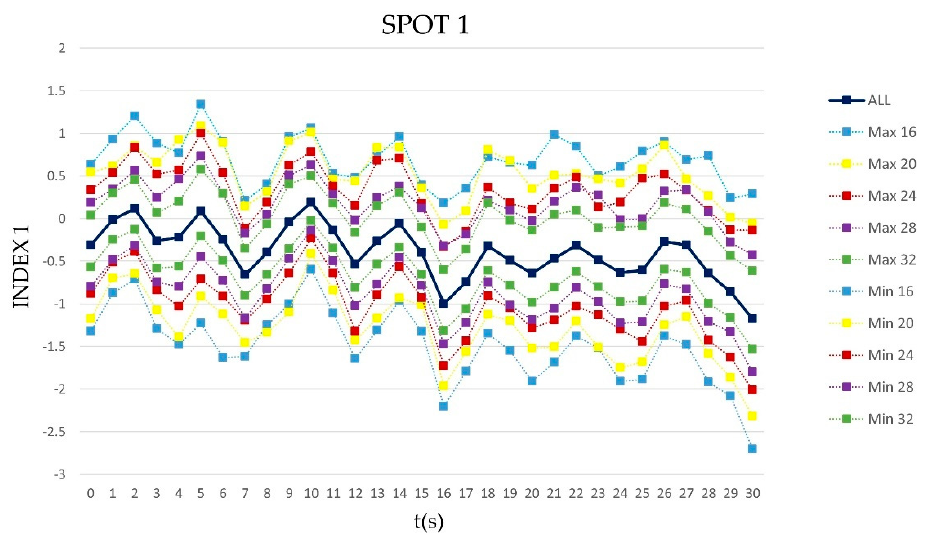
Figure 1. The graph represents the trend of ‘ v ’, the mean value of Index1 computed over the entire population (36 subjects) during SPOT1 (ALL). The dashed lines show the trend of the maximum and minimum values (Max, Min) of the index among the ‘ v630 ’ for each second, in each subgroup of subjects (32, 28, 24, 20, 16).